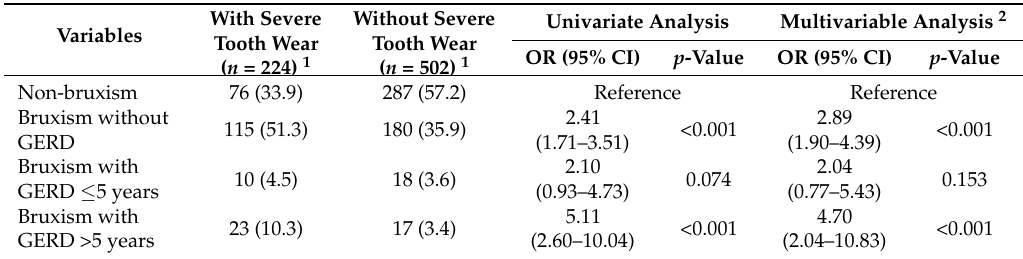
Table 3. Associations among bruxism, GERD, and severe tooth wear for the whole dentition.